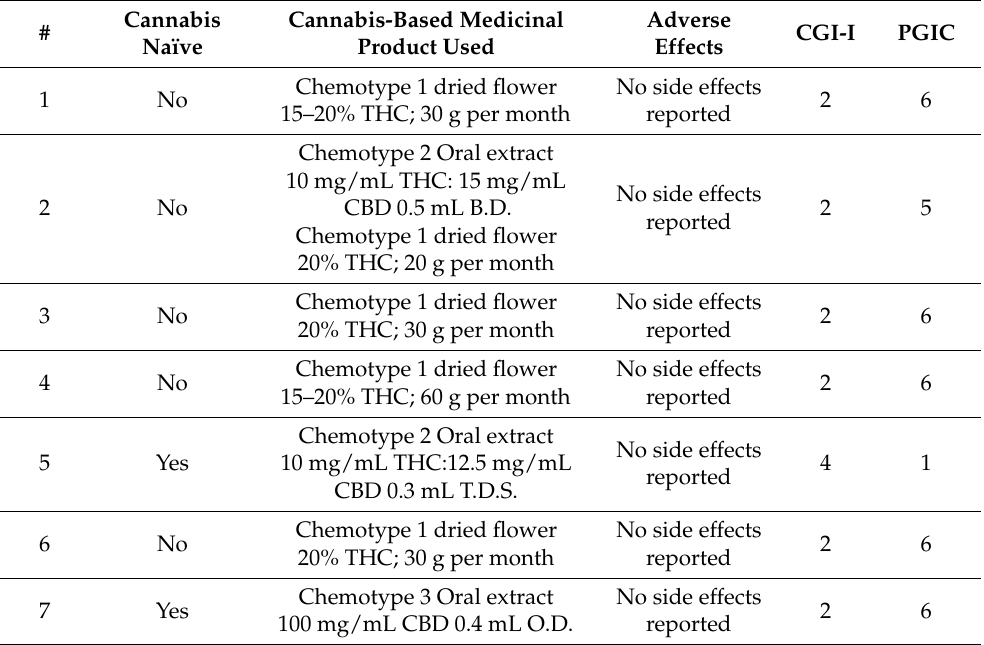
Abbreviations: #, participant number; THC, tetrahydrocannabinol; CBD, cannabidiol; O.D., omni die (once a day); B.D., bis die (twice a day); T.D.S., ter die sumendus (three times a day); CGI-I, Clinical Global Impression–Global Improvement (CGI–I) Scale; PGIC, Patients’ Global Impression of Change (PGIC)